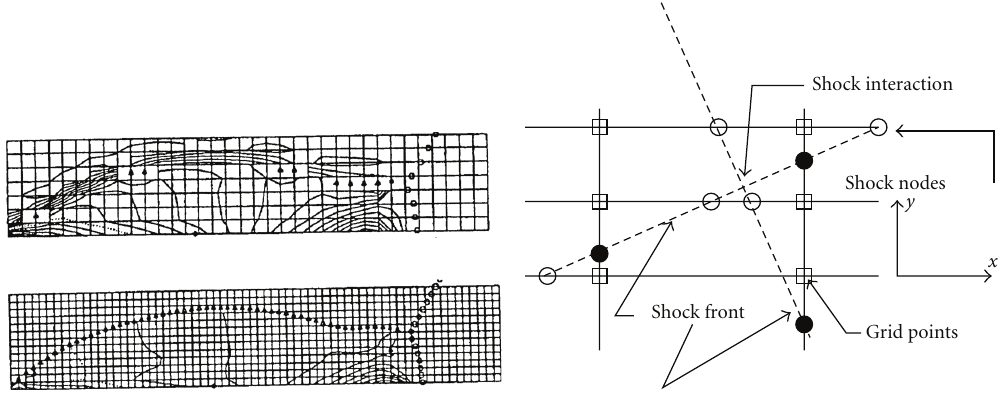
Figure 9: Floating shock